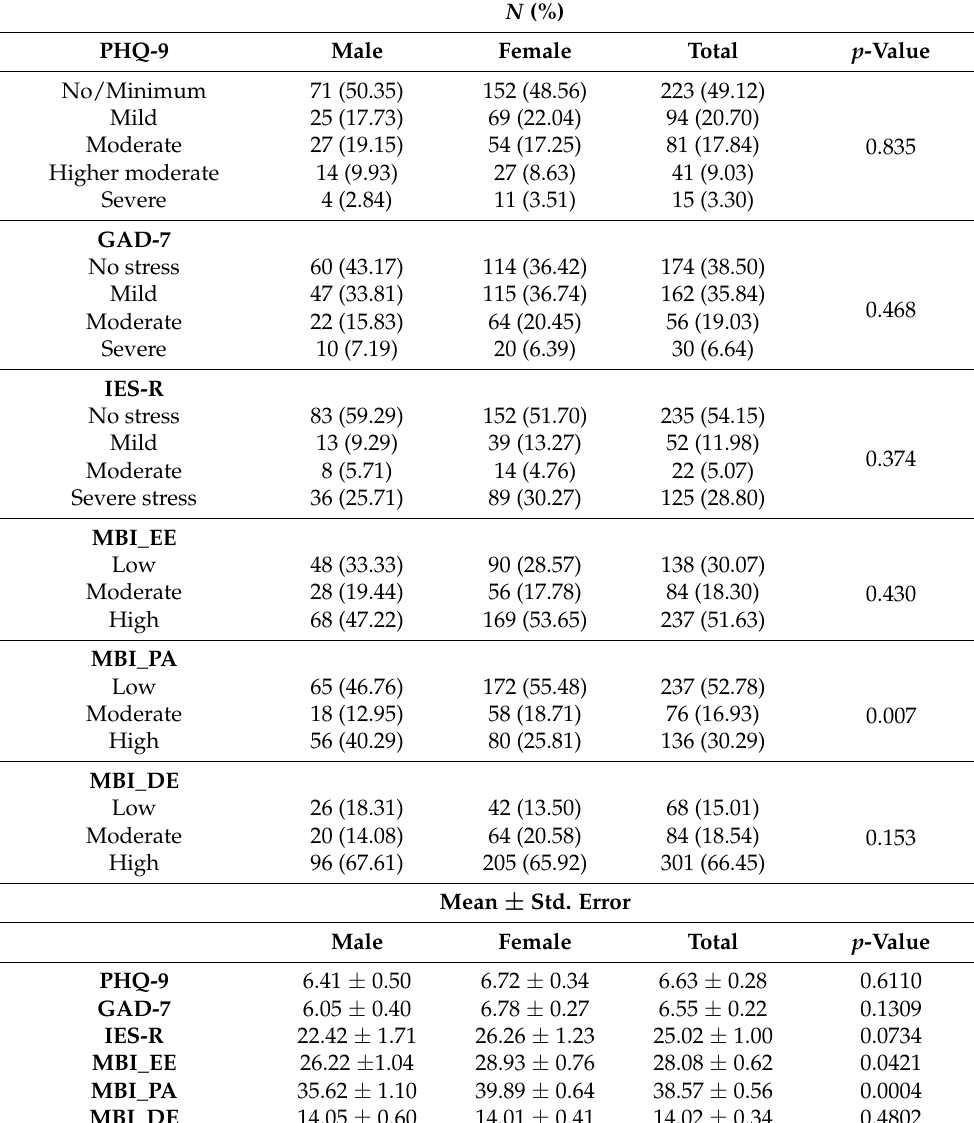
Table 2. Psychometric scale outcomes: means and level of severity by sex and total. PHQ-9 = Patient Health Questionnaire-9; GAD-7 = General Anxiety Disorder-7; IES-R = Impact of Event